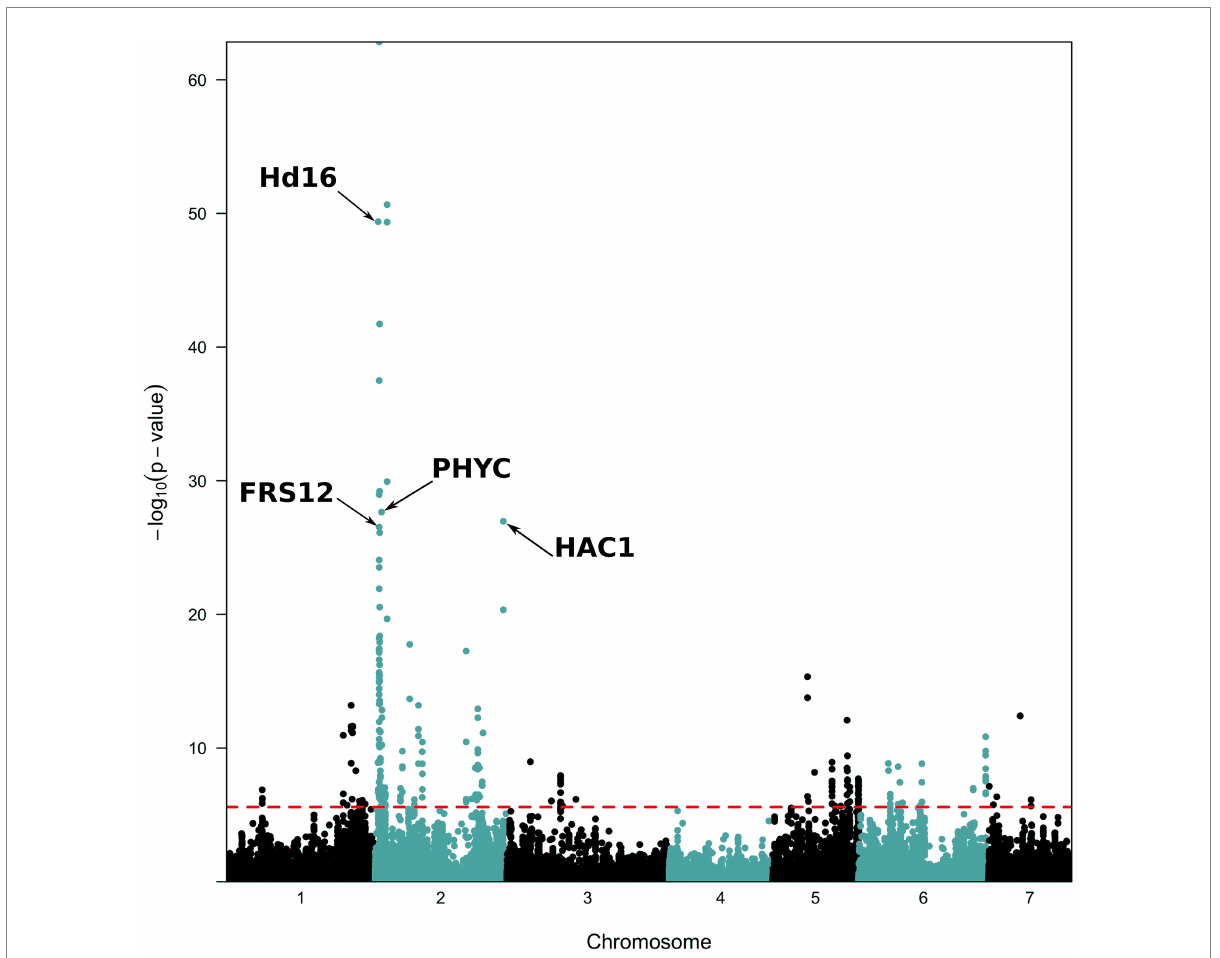
FIGURE 4 Manhattan plots of p -values for PCAdapt analysis along the genome. The analysis was performed on the 96,881 SNPs with a MAF ≥ 5%. The red dashed line represents the 0.001 false discovery rate (FDR) value considered for